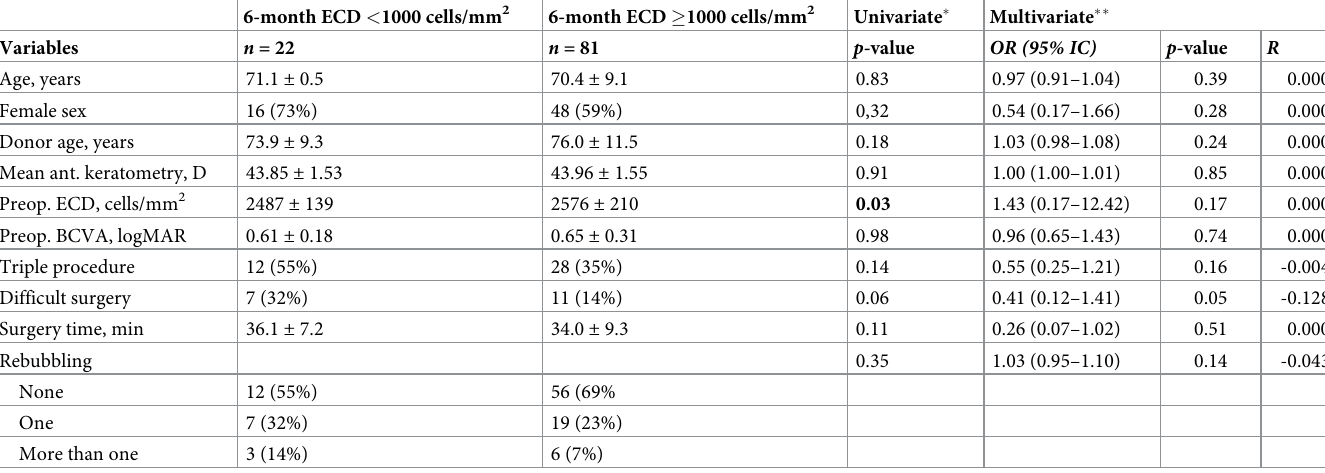
Table 4. Comparison of patients with 6-month ECD < 1000 and � 1000 cells/mm 2 in terms of preoperative and perioperative variables.